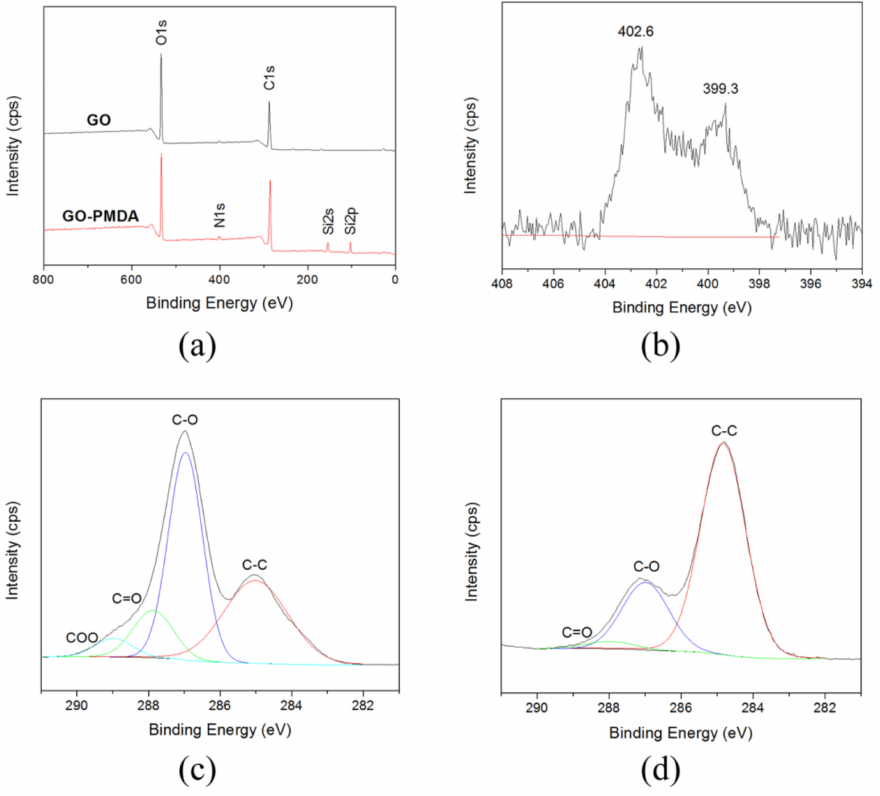
Figure 3. XPS survey spectra of the GO and GO-PMDA ( a ) and high-resolution XPS spectra of N1s for GO-PMDA ( b ), C1s for GO ( c ), C1s for GO-PMDA ( d ).